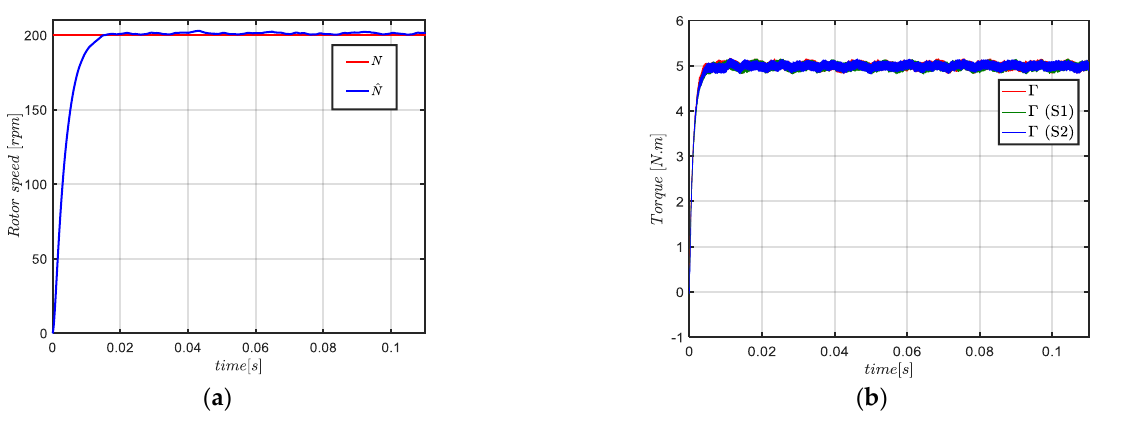
Figure 17. Simulated waveforms: ( a ) actual and estimated rotor speed, ( b ) torque when the seven- phase PMSM is controlled by the encoder, sensorless control ( S1 ) and sensorless control ( S2 ).